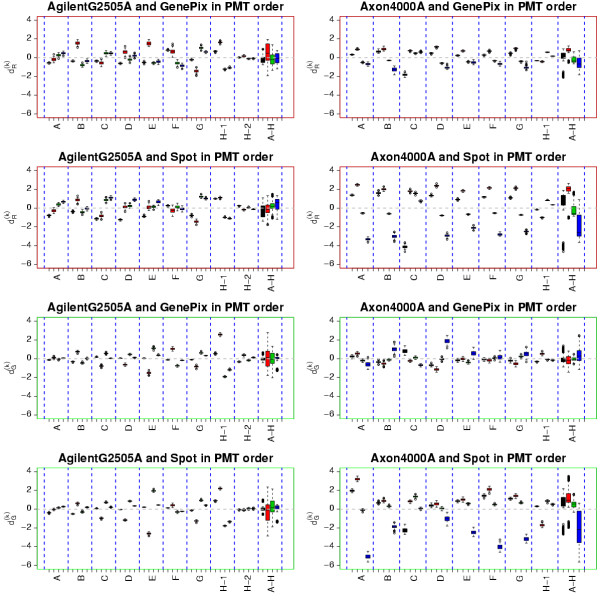
Bias residual estimates for all arrays. Estimated bias residuals  for each array and for all arrays together from the Agilent scanner (left column) and the Axon scanner (right column). For each array the distribution of the four of  are shown in increasing PMT order. The top four graphs are for the red channel and the bottom four are for the green channel. For each channel the top two are estimates based on signals quantified by GenePix and the bottom two on signals quantified by Spot.